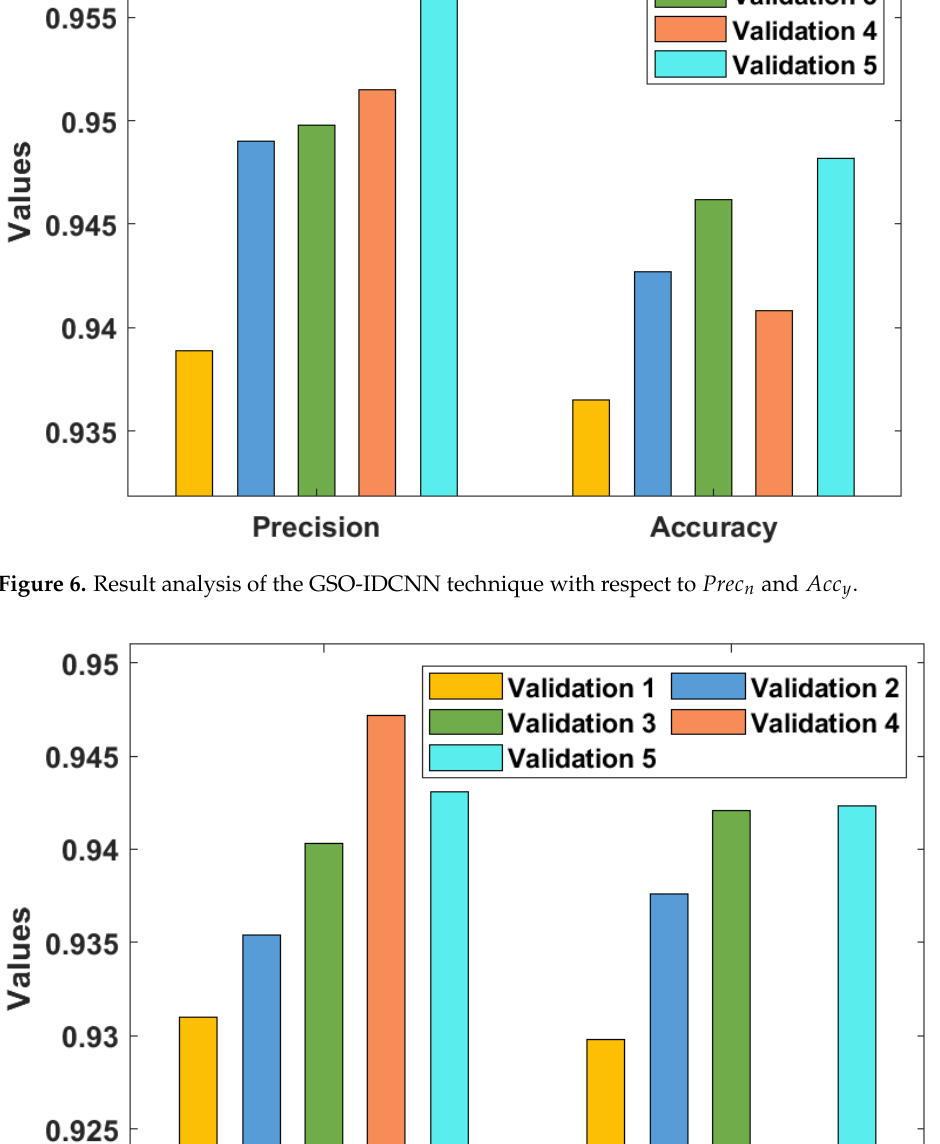
Figure 5. Result analysis of the GSO-IDCNN approach with respect to 𝑠𝑒𝑛𝑠 𝑠𝑝𝑒𝑐 . 𝑦